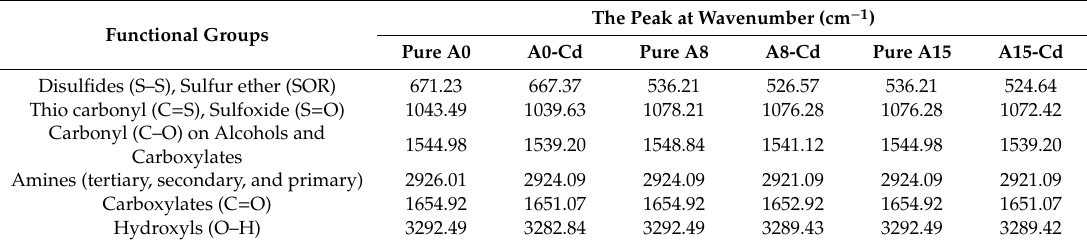
Table 1. The observed shifting main peaks of FTIR spectra for biosorbent.